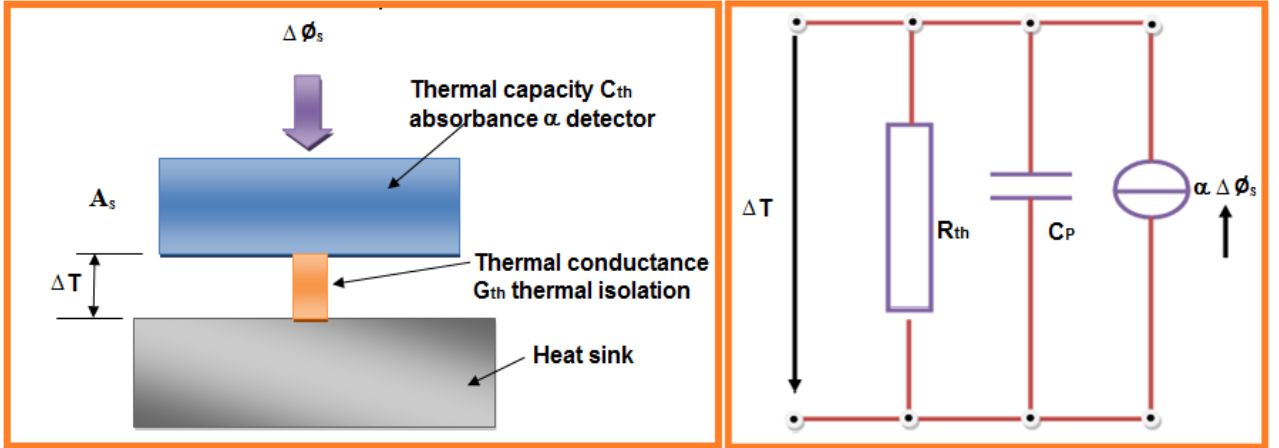
Figure 11. Thermo physical model of thermal infrared sensors in thermography technique.